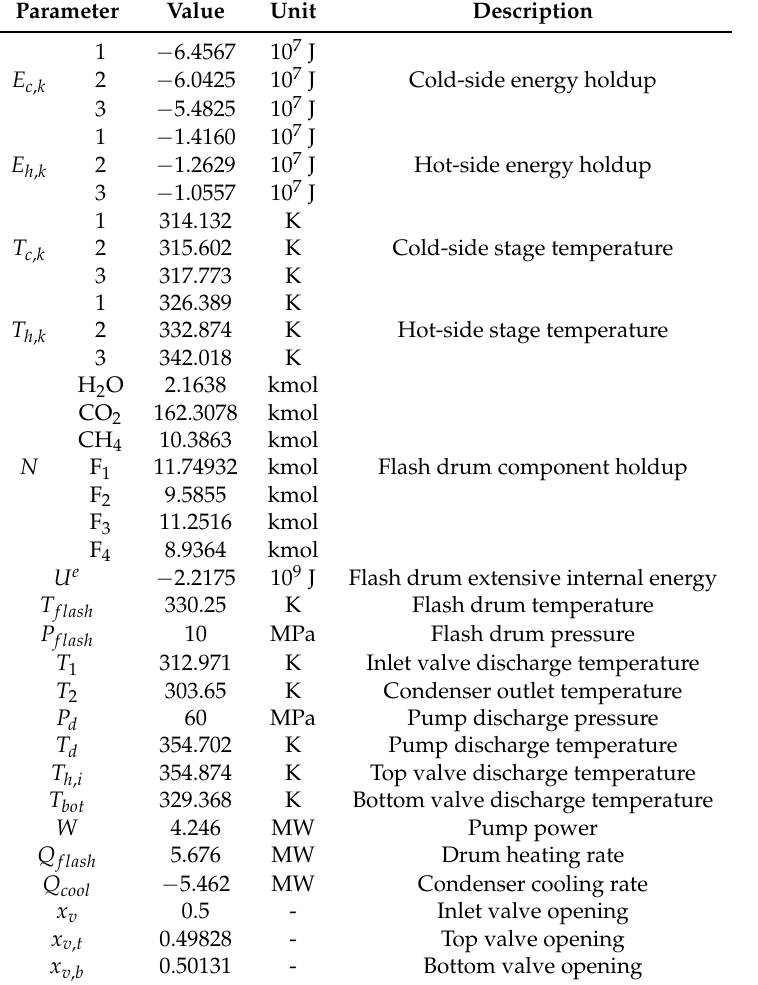
Table A3. Nominal